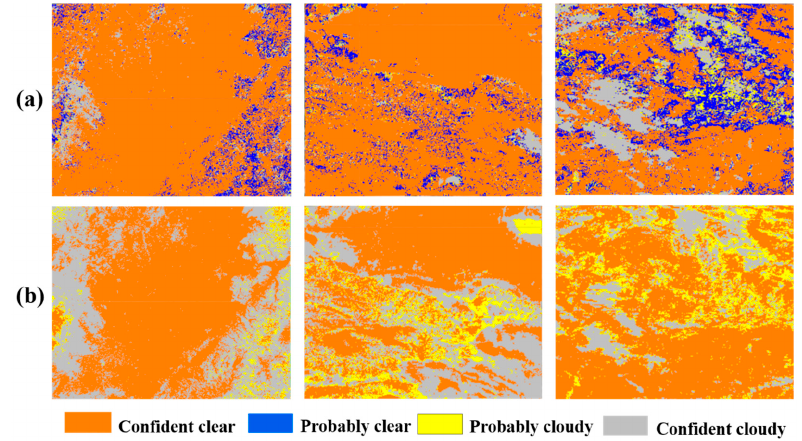
Figure 8. The confidence level distribution in ( a ) VIIRS and ( b ) MODIS. The test regions with DOY are shown from left to right: NE (2020002), NW (2020038) and QT (2020047).